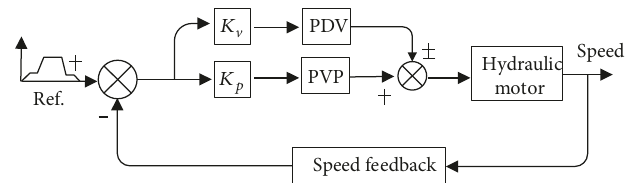
Figure 2: Control principle of valve-pump parallel variable mode control.